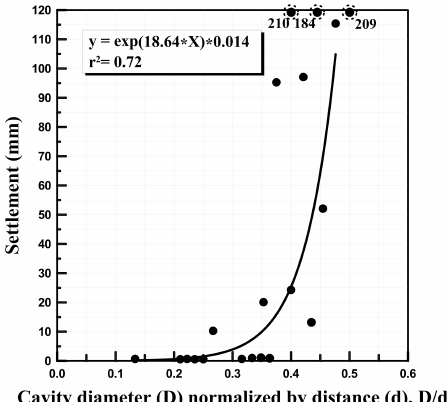
Figure 7. Regression analysis of roadbed settlements with respect to the diameter of the cavity and distance between the roadbed and the